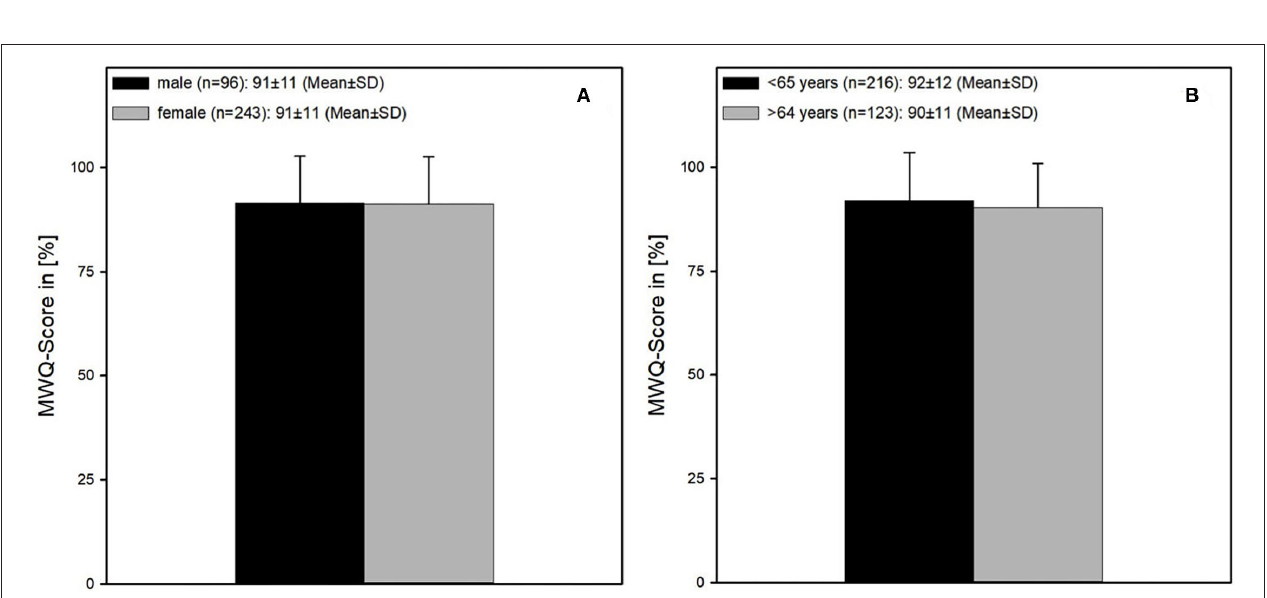
FIGURE 6 | Wrist function according to the MWQ. (A) Male and female patients showed no difference concerning the wrist function (both 91 ± 11% MWQ-Score). (B) Age also had no influence on function regarding the patients older and younger than 65 years (age < 65 and > 64 years = 92 ± 12 vs. 90 ± 11).